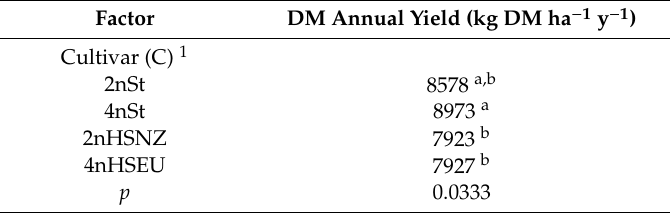
Table1. Annualdrymatter(DM)yieldoffour Loliumperenne